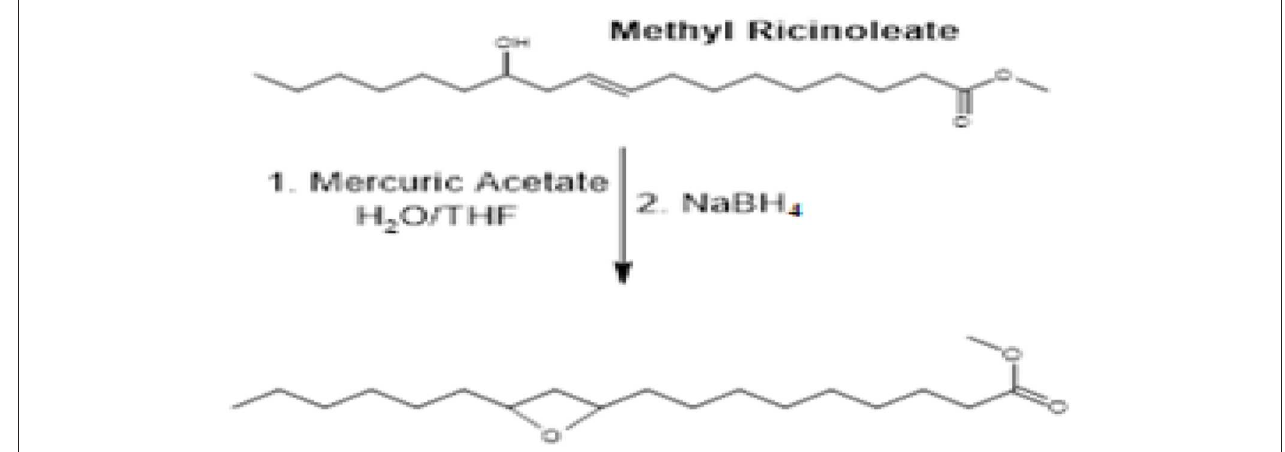
FIGURE 3 | Conversion of methyl recinoleate to cis-10,12epoxy-12-hydroxystearate and its rearrangement product, hydroxy